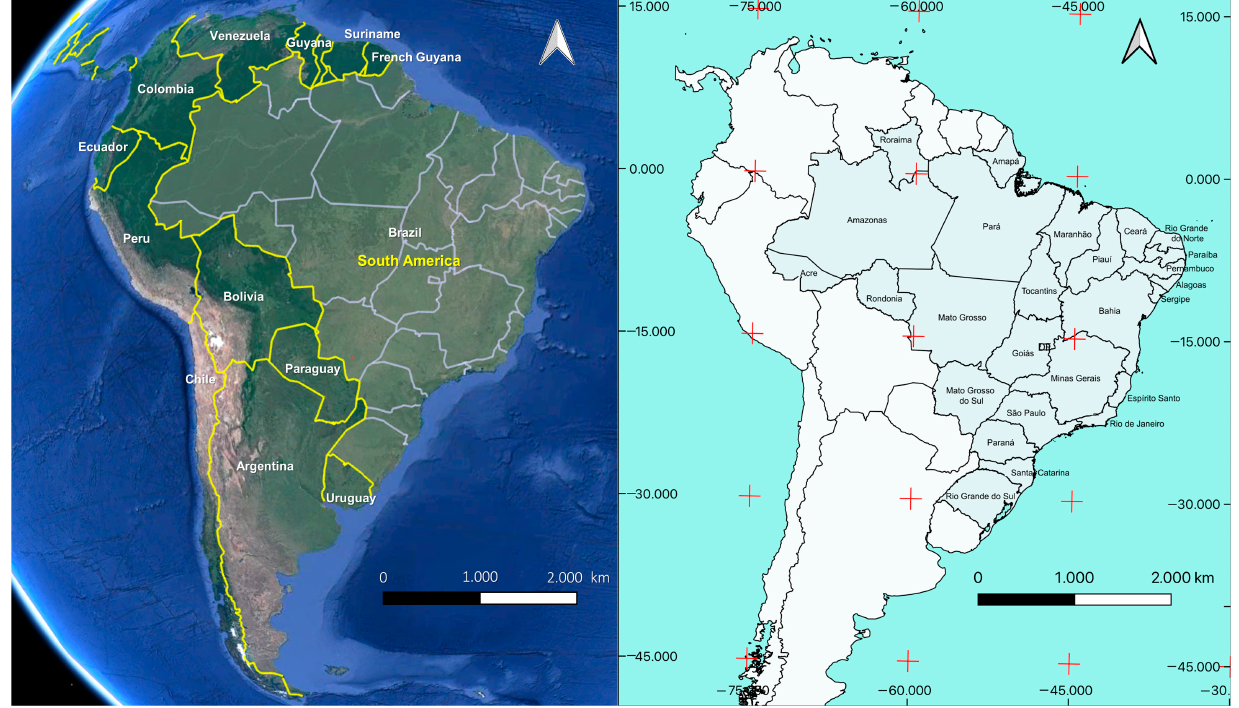
Figure 1. South America political map showing Brazil with international borders, neighboring countries and states.